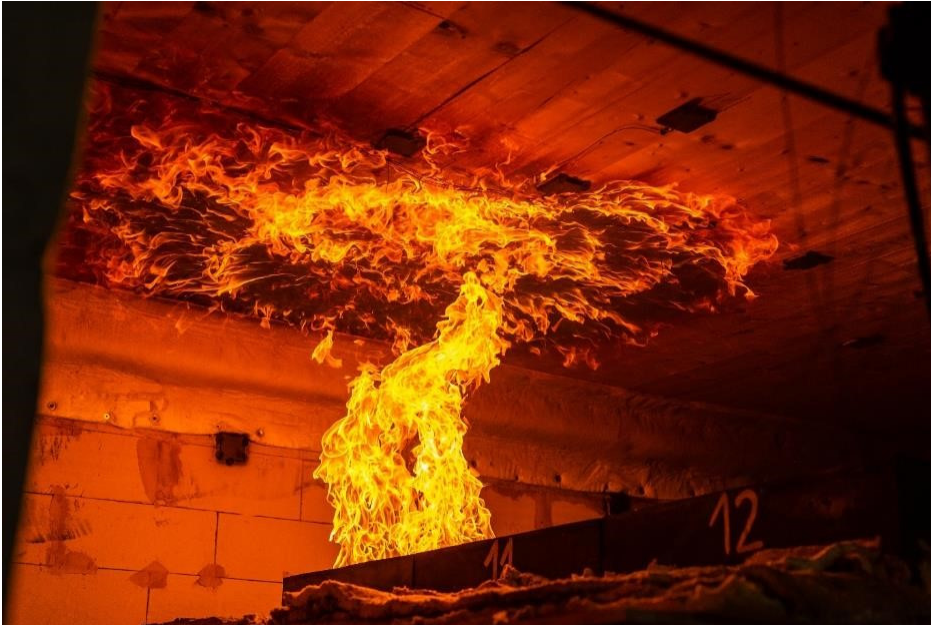
Figure 3. Flames from burner impacting ceiling in Experiment 3.